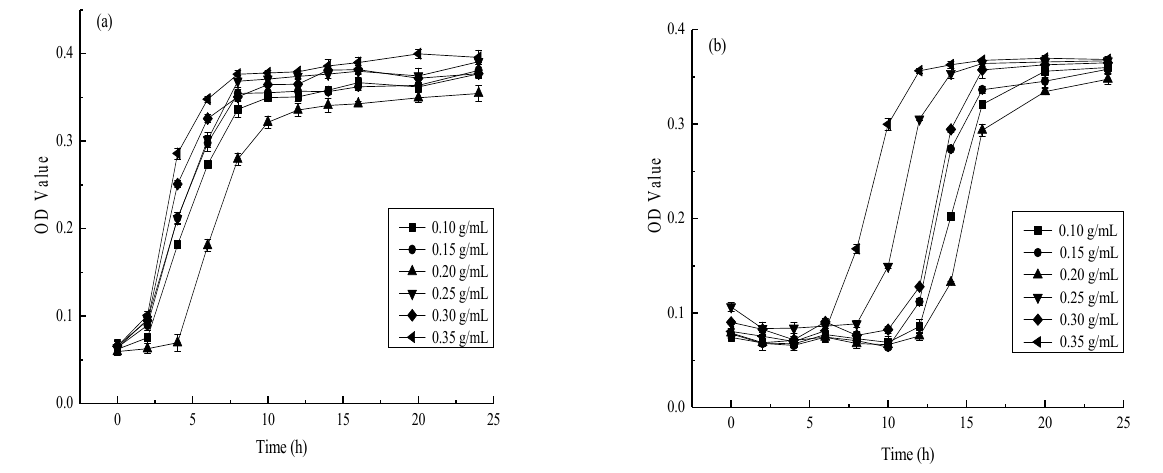
Figure 2. Effects of different silver nanoparticles on the antibacterial activity of E. coli (( a ) Nanosilver sol concentration is 20% nanosilver sol stock solution, ( b ) Nanosilver sol concentration is 40% nanosilver sol stock solution).